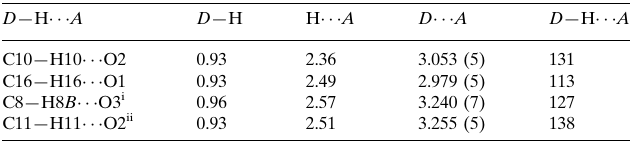
Hydrogen-bond geometry (A˚ , (cid:2)